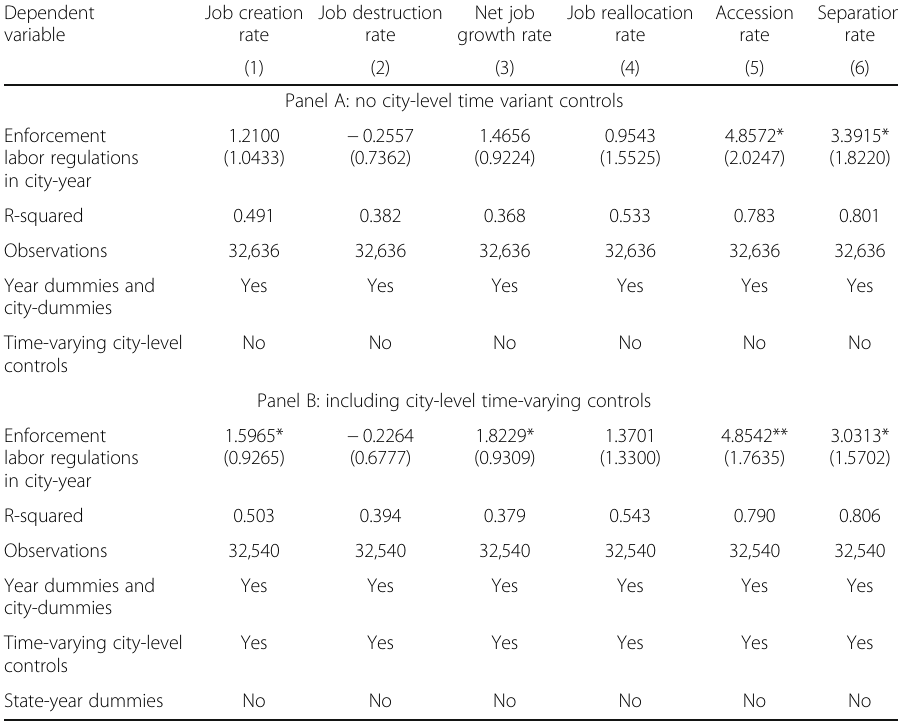
Table 8 Enforcement of labor Regulations and job flow